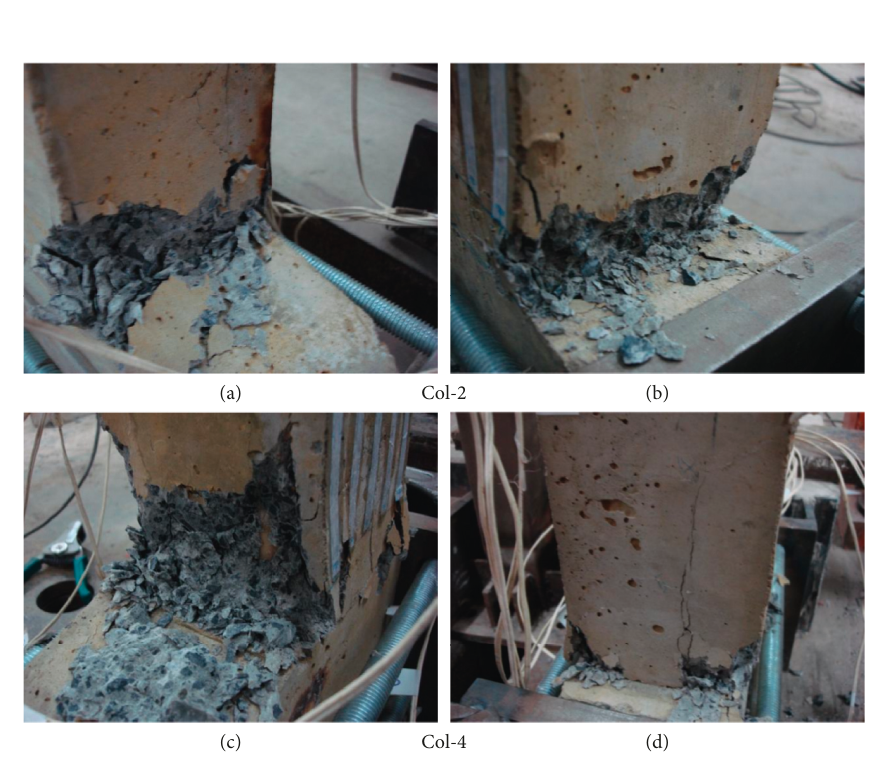
Figure 6: Failure pattern of columns: forward loading (a, c) and reverse loading (b, d).